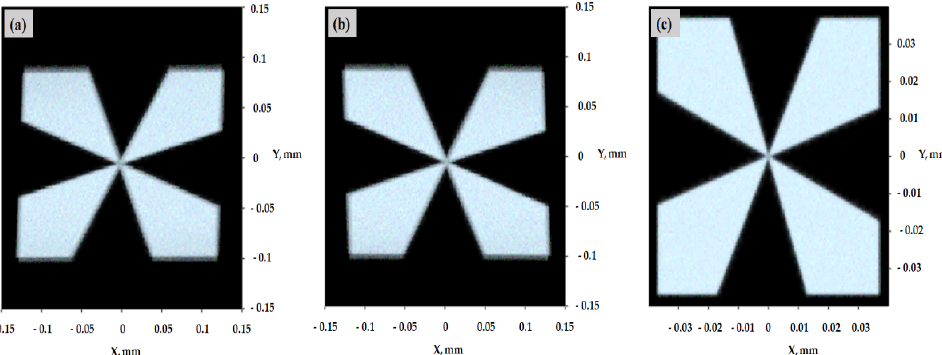
Figure 3. Simulated images at the retina. The images viewed by ( a ) the left eye and ( b ) the right eye through the double-mirror system. ( c ) A directly viewed image of a target at 2285 mm.